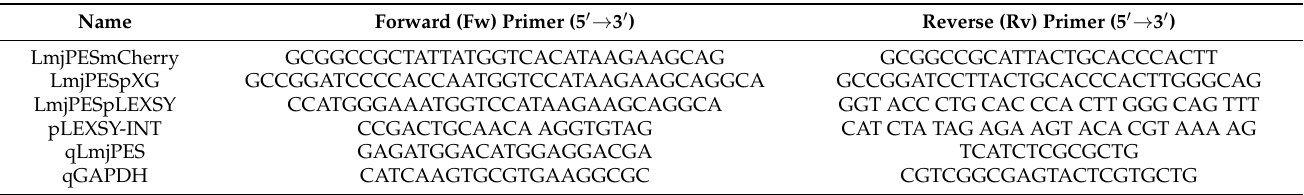
Table 1. Primer sequences employed for the genetic manipulation of Leishmania parasites.